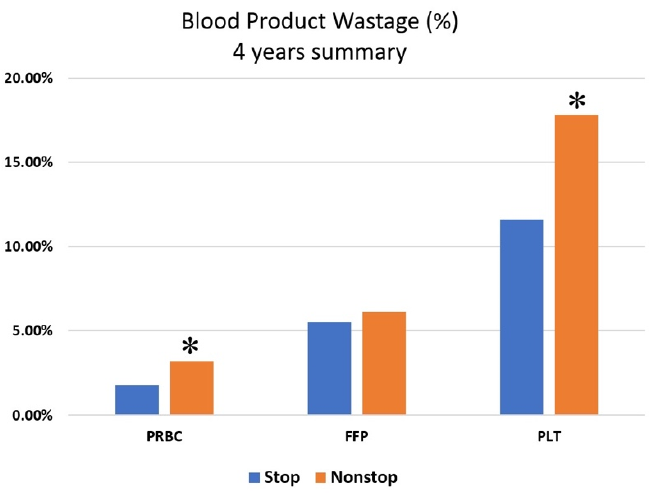
Figure 1. Average % wastage of issued blood components over the four years for normal-stop and nonstop MTP activations . The relative risk of wastage was calculated for individual blood and nonstop MTP activations. The relative risk of wastage was calculated for individual